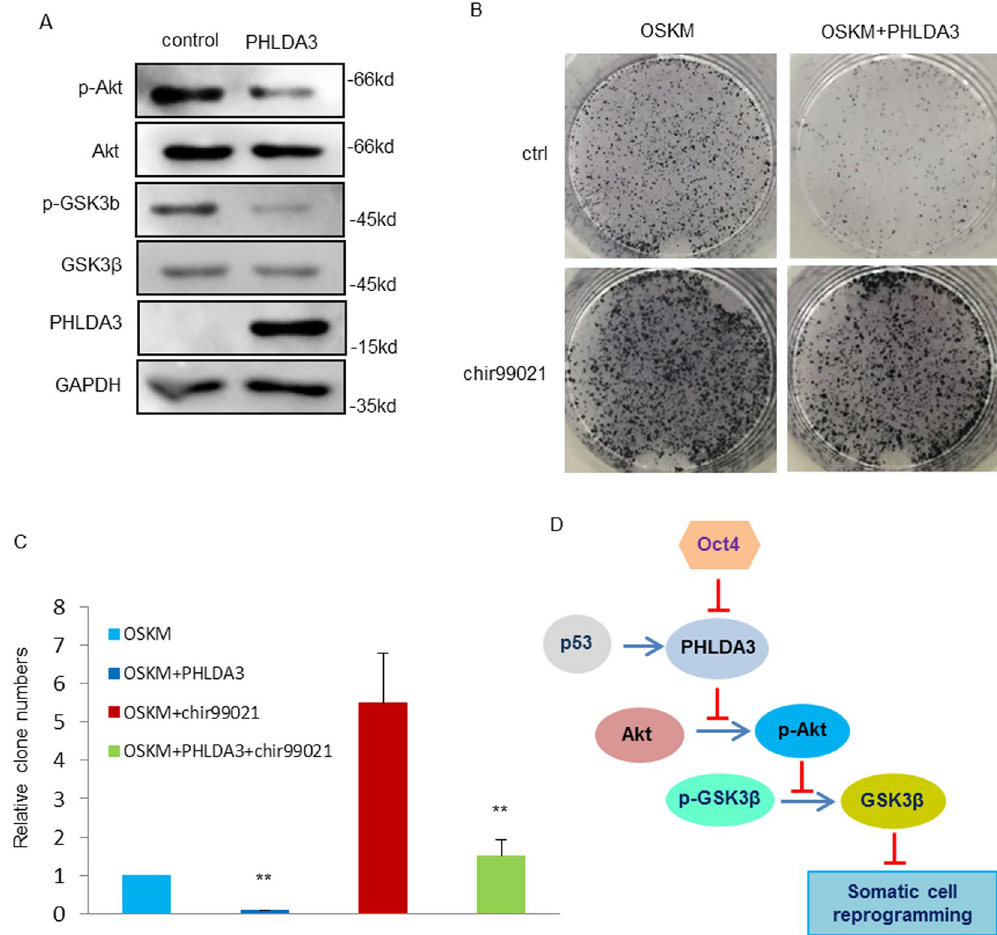
Figure 4. PHLDA3 inhibits iPSCs generation through activating GSK3 β . ( A ) MEF cells expressing OSKM were infected with either pMXs or pMXs-PHLDA3 for 4 days, then cell lysates were analyzed with the indicated antibodies. ( B , C ) MEF cells expressing OSKM were infected with either pMXs or pMXs-PHLDA3, then MEF cells were induced for iPSCs with and without 3 uM chir99021. GFP positive clones were calculated at 10 days ( C ) and then transferred onto new feeder cells for another 5 days before subjected to AP staining ( B ). ( D )